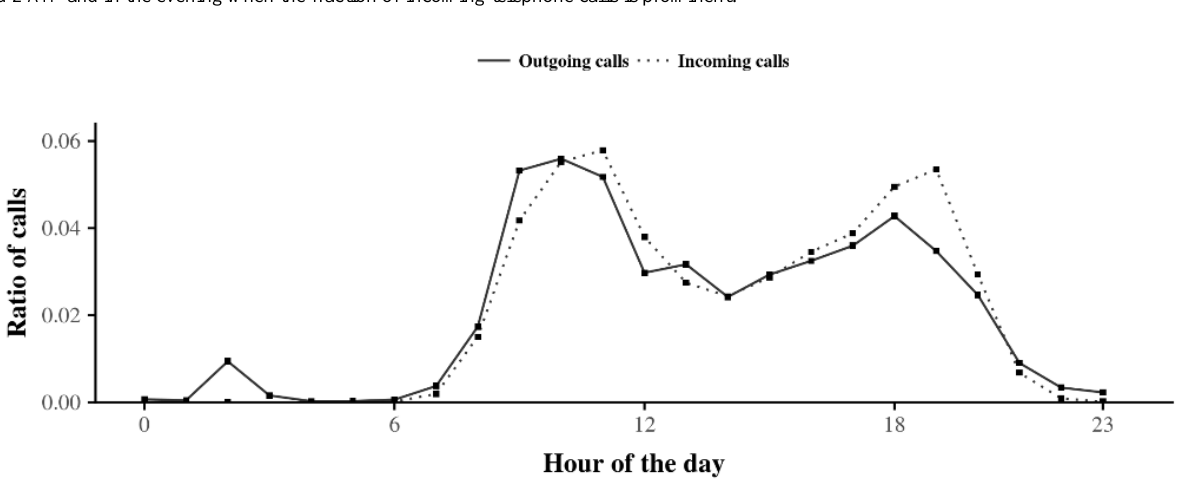
Figure 1. Daily rhythm of telephone calls of older adults at the aggregate level for outgoing and incoming telephone calls. The shape of the curves suggests that similarities exist in how older adults place and receive telephone calls during the day. It also suggests differences, especially at night around 2 AM and in the evening when the fraction of incoming telephone calls is prominent.